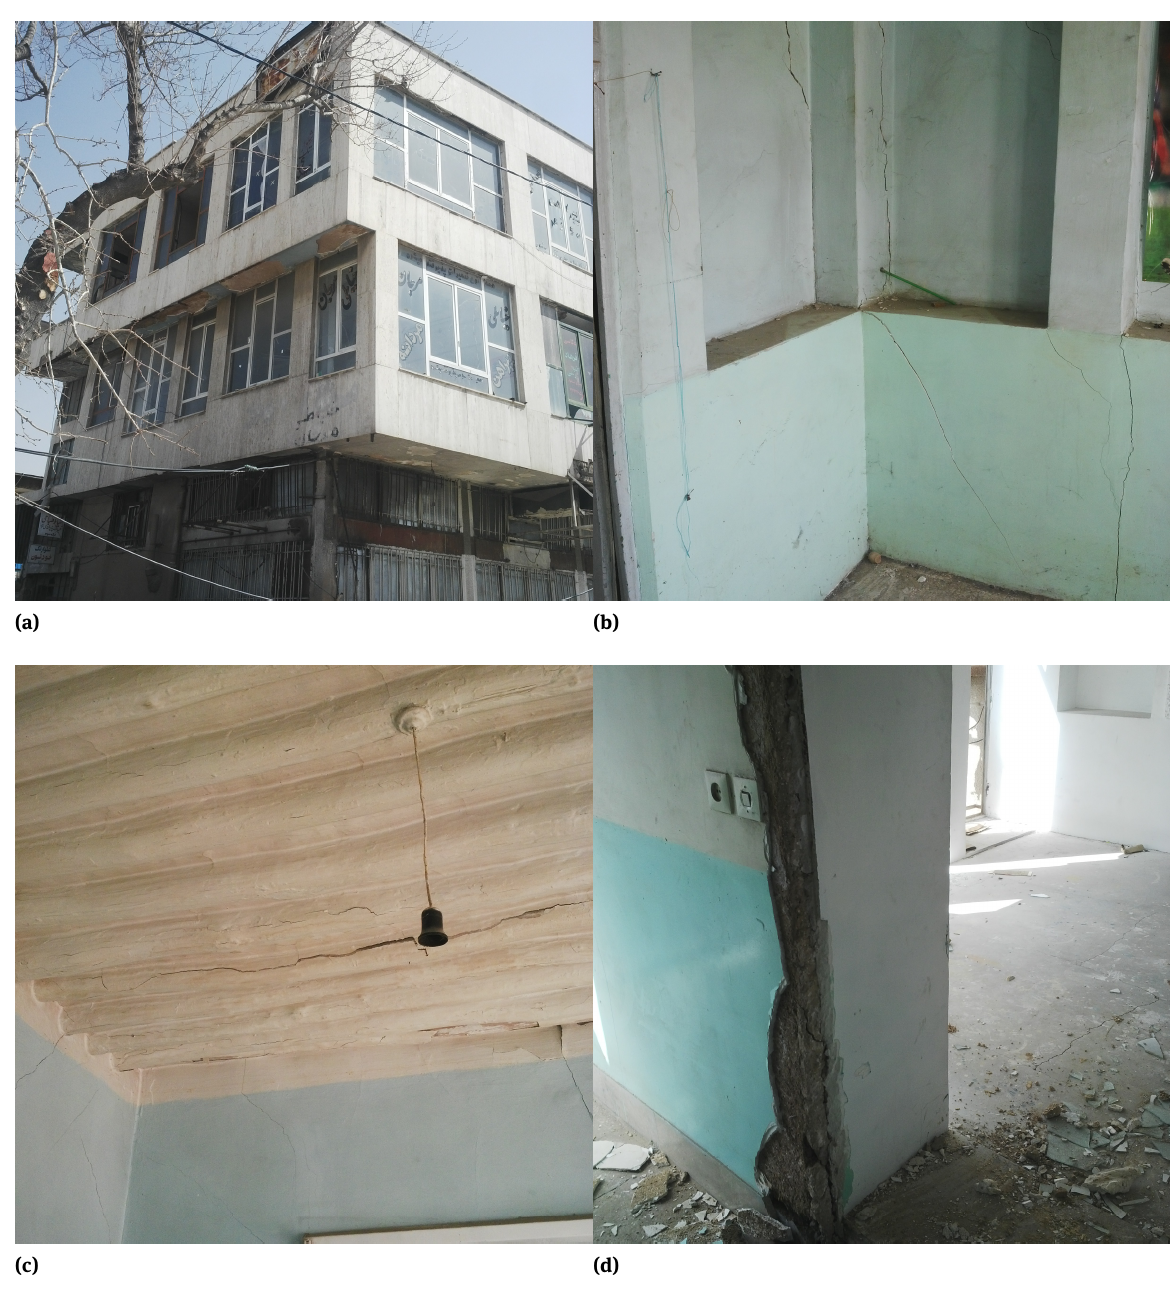
Figure 4: Structural damages to masonry buildings due to passage of subway trains, (a) the shattered glass and the plaster cover fell under the roof, (b) cracks in walls, (c) cracks in ceiling and (d) spalling of plaster wall